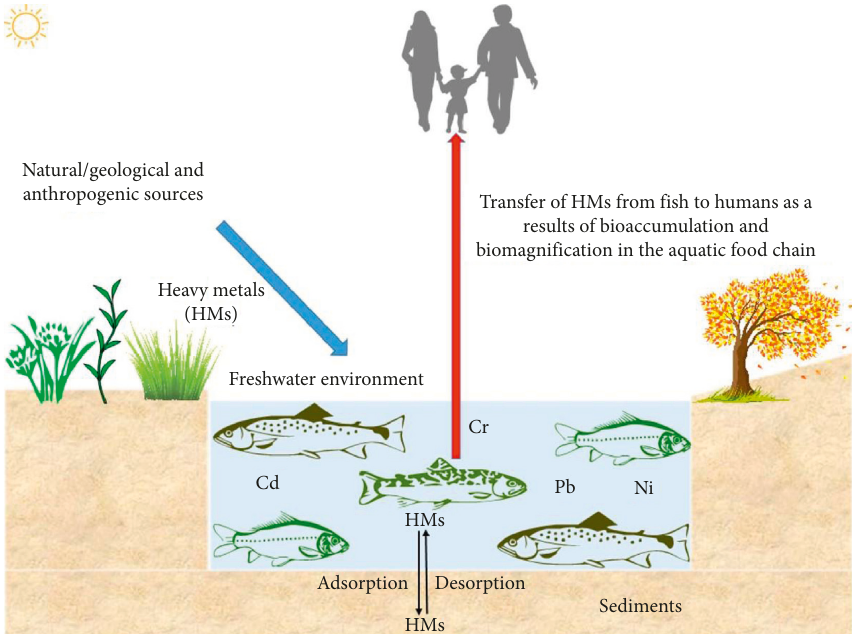
Figure 4: Trophic transfer of heavy metals from freshwater fish to humans in the human food chain.